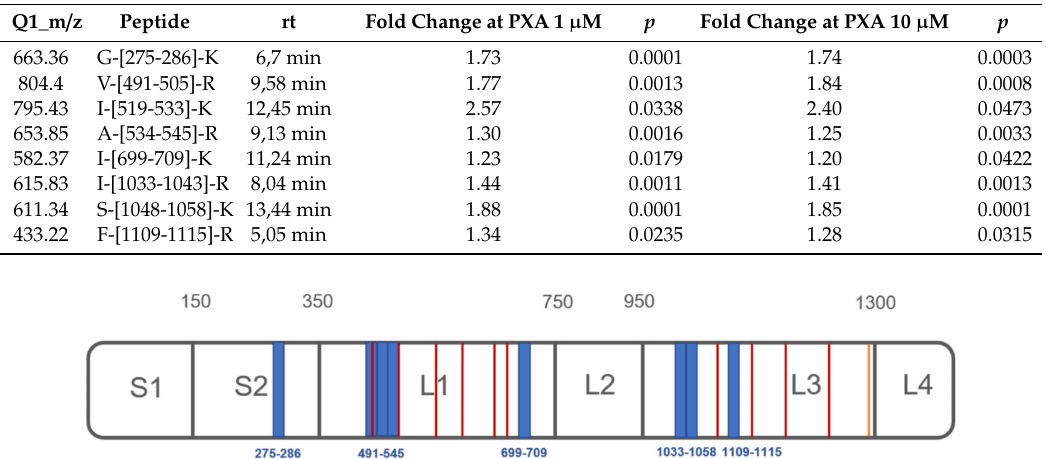
Table 1. Selected carbamoyl-phosphate synthase-1 (CPS1) peptides reported with their Q1 m / z value, their length, the retention time in UPLC-MS, and the calculated fold changes. The fold change represents the ratio between the area of the tryptic peptide in the PXA-treated sample and the area of the tryptic peptide in the untreated sample. The same experiments have been repeated three times, and the fold changes were calculated over the means of the peptides’ area. p have been calculated, and only tryptic peptides with a p < 0.05 are reported.